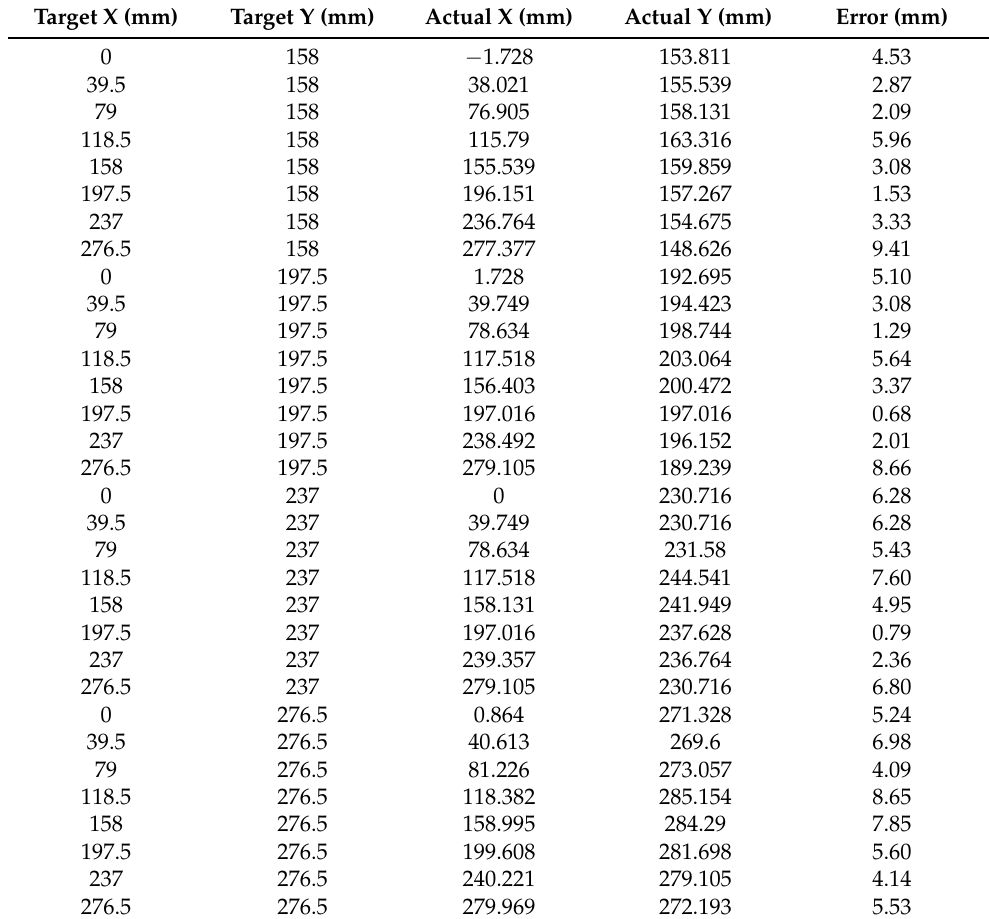
Table A2. Run 1 positional data (upper half of the network).